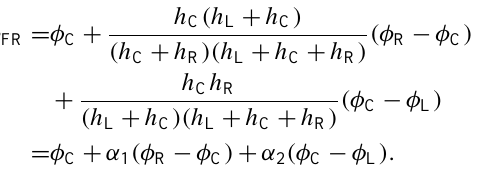
Table 2. Coefficient table for ROS2. A second method was constructed from a low stor- 250 age three stage second-order Runge-Kutta method, which is used in split-explicit time integration methods in the Weather Research and Forecasting (WRF) Model (Ska- marock et al., 2008) or in the Consortium for Small-scale